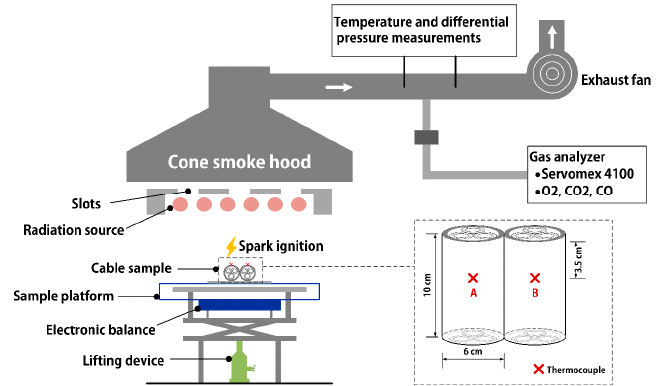
Figure 2. Schematic of the calorimeter apparatus.